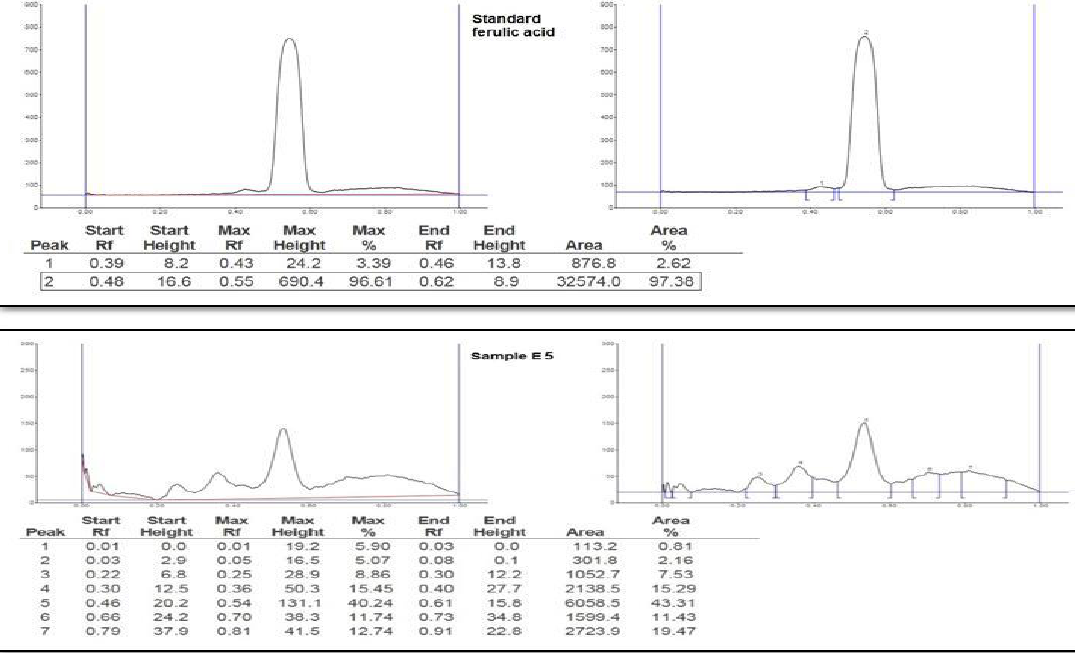
Figure 7. HPTLC chromatogram of standard and sample E5 ferulic acid at